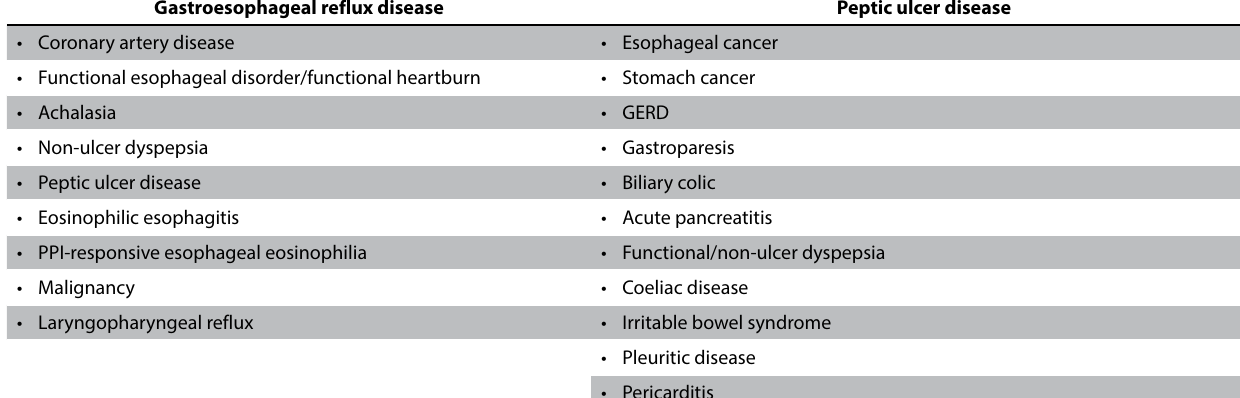
Table 3: The differential diagnosis of GERD and